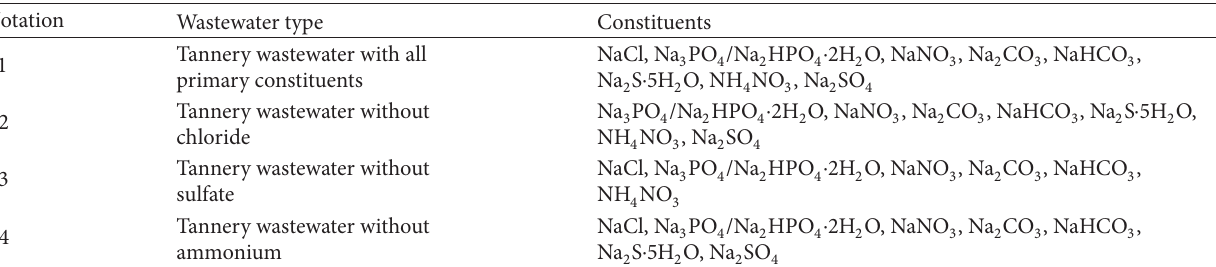
Table 4: Different types of tannery wastewater used in the